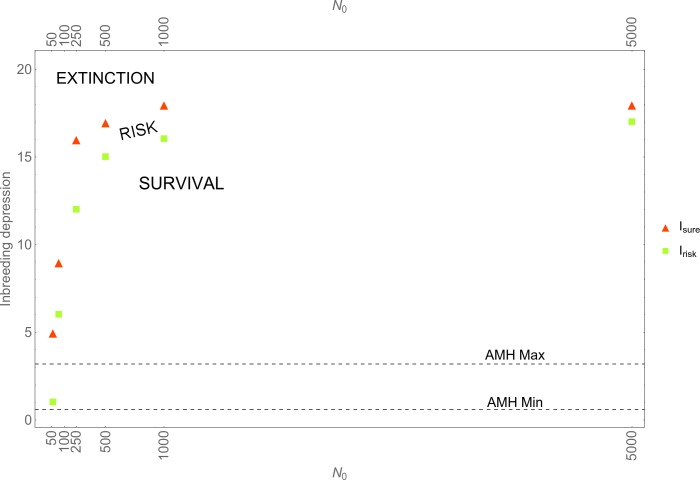
Inbreeding and stochasticity.Irisk (lowest value of inbreeding depression parameter I that results in at least one extinction event in ten simulation runs) and Isure (lowest value of inbreeding depression that results in extinction in all simulation runs) for various initial population sizes N0 and fi = 50% (for fi = 30;70, see S1 Appendix). The horizontal dotted lines mark the range of values of I observed in AMHs.